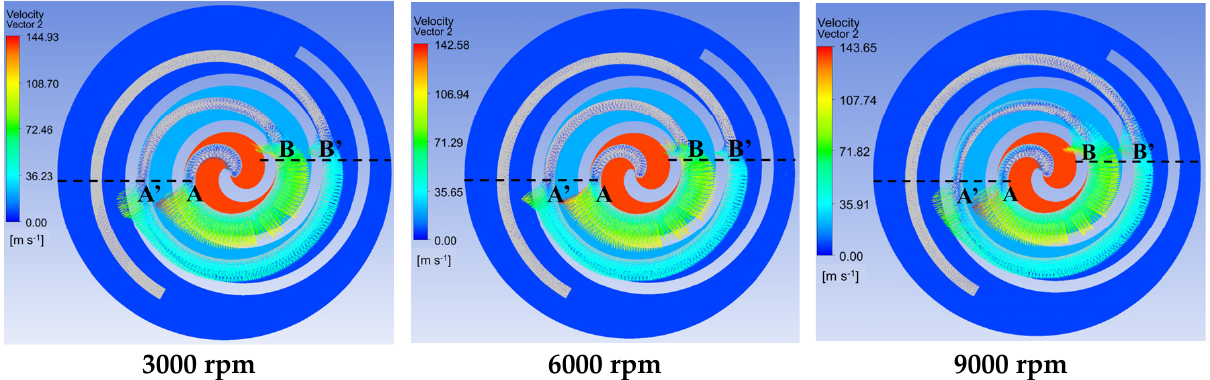
Figure 15. Velocity distribution on a cross-section of the bottom axial clearance domain (z = 20.015 mm).